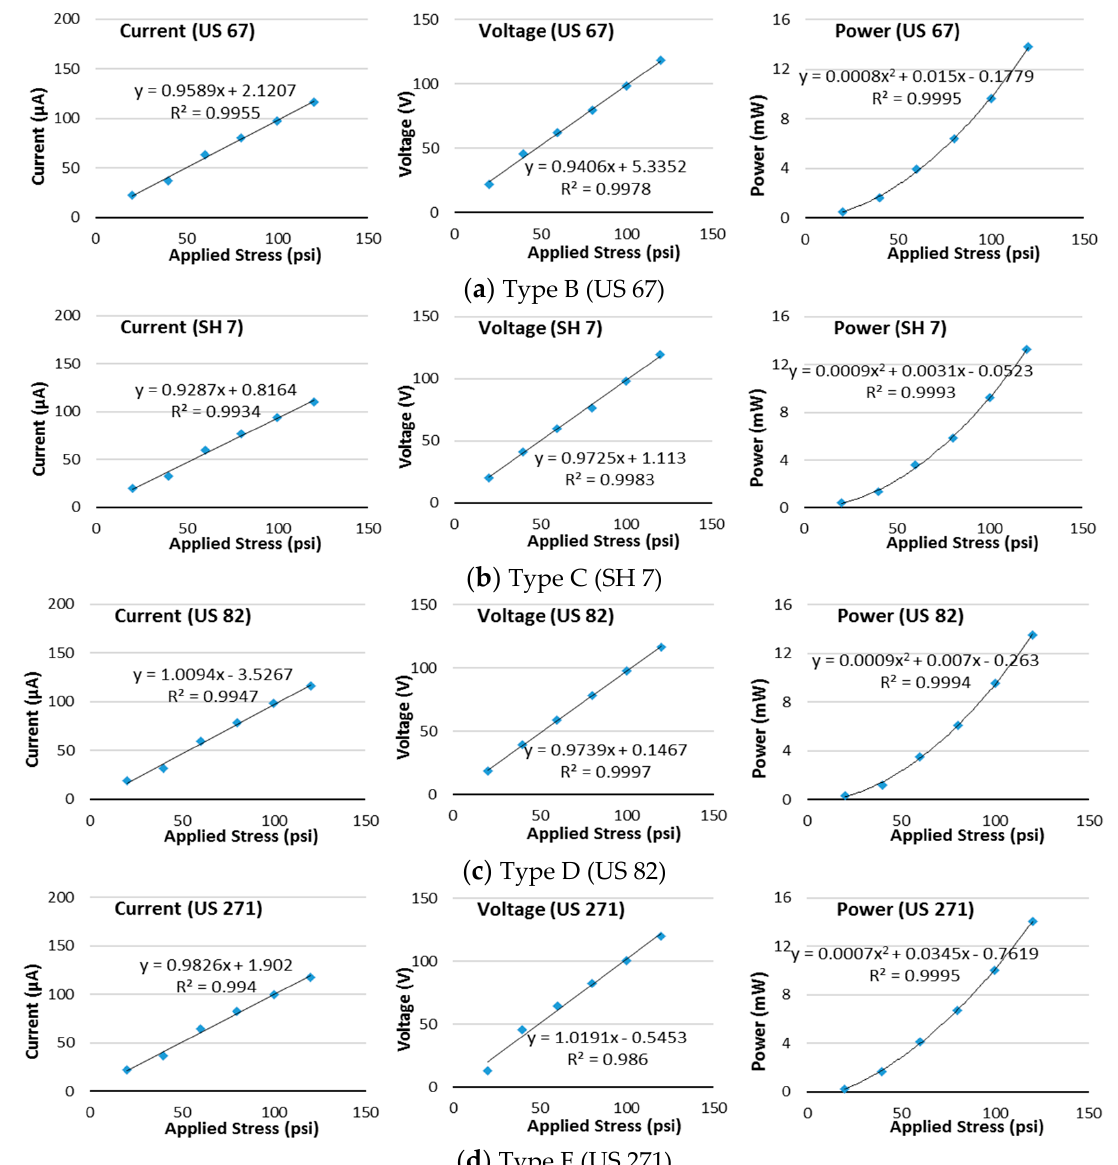
Figure 9. UTM-HiSEC Stress-Energy Correlations (1 Hz, 20 °C).